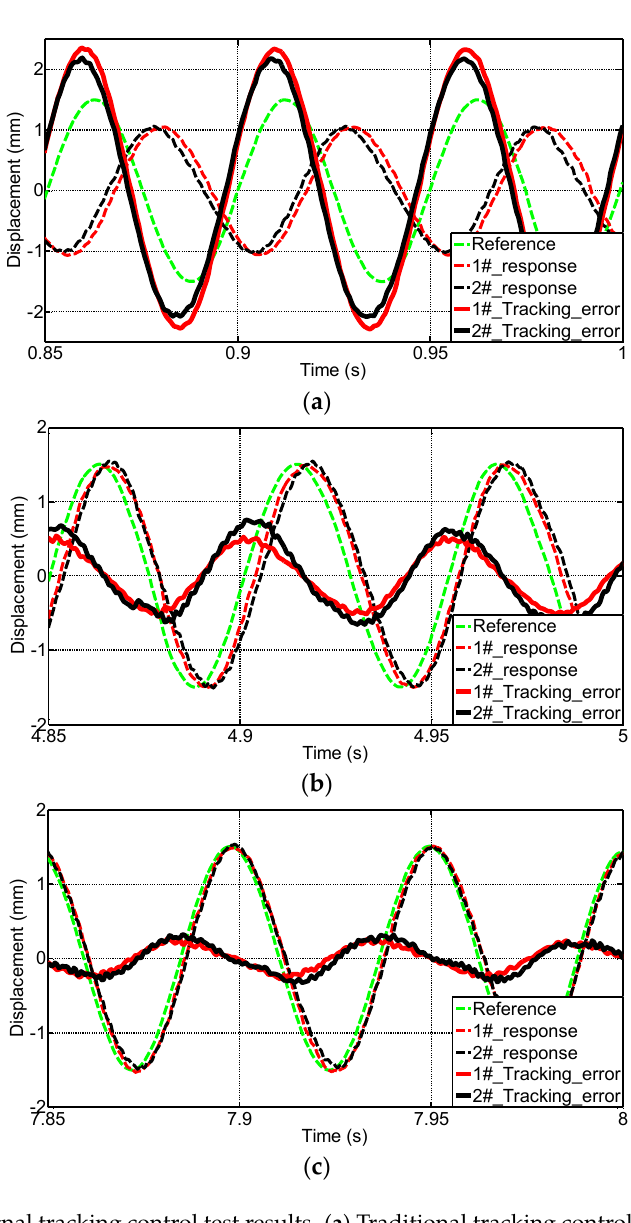
Figure 24. Sine signal tracking control test results. ( a ) Traditional tracking control; ( b ) Feed-forward inverse compensation tracking control; ( c ) Proposed tracking control. Appl. Sci. 2016 , 6 , 220